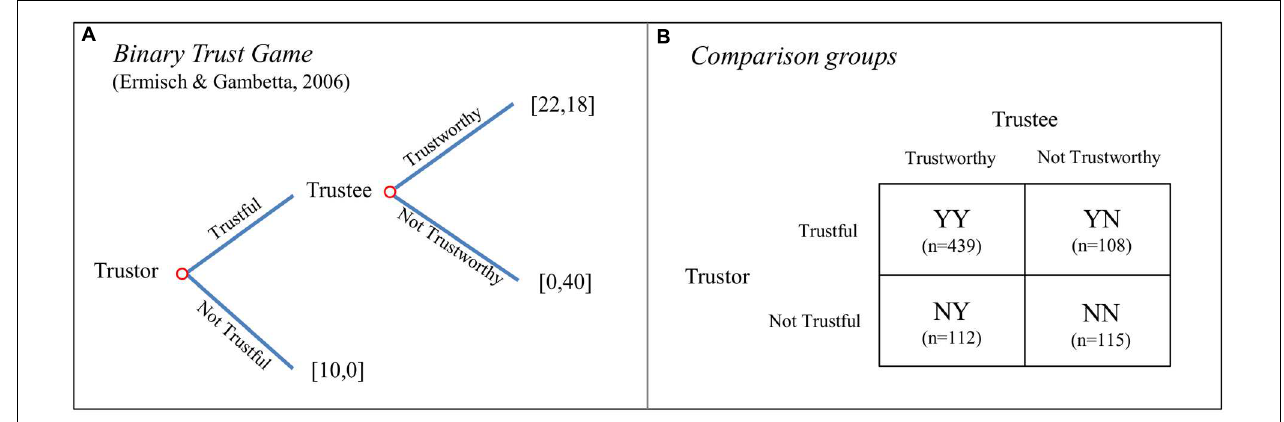
FIGURE 1 | Trust Game Strategies. (A) Describes the binary Trust Game while (B) depicts the classification of the strategies (number of subjects in each group in parentheses).